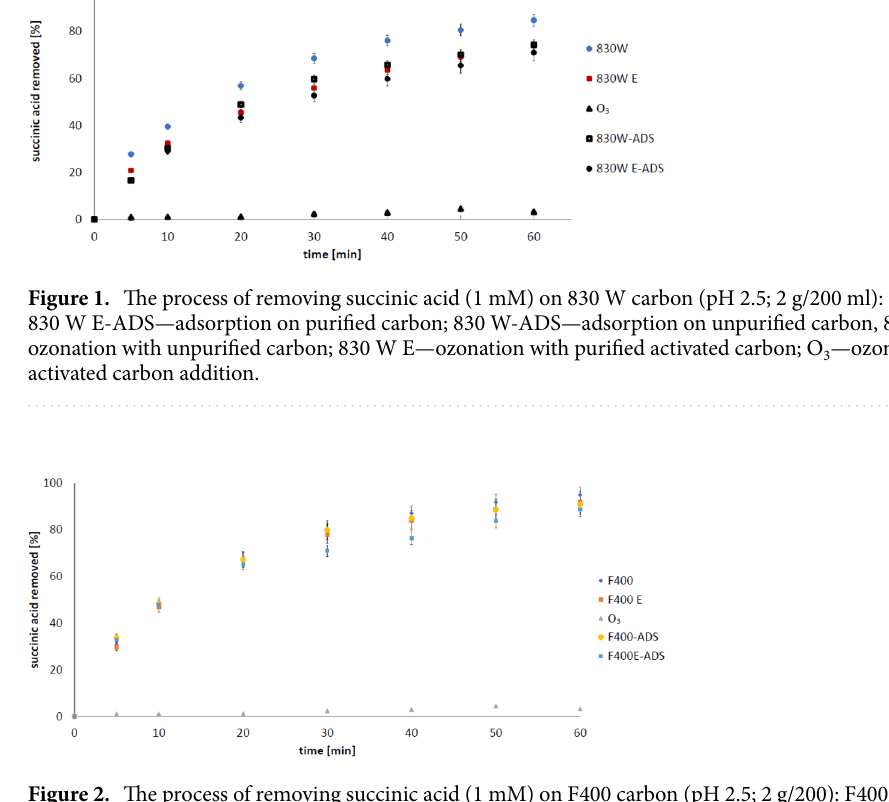
Figure 2. The process of removing succinic acid (1 mM) on F400 carbon (pH 2.5; 2 g/200): F400E‑ADS— adsorption on purified carbon; F400‑ADS—adsorption on unpurified carbon, F400—ozonation with unpurified